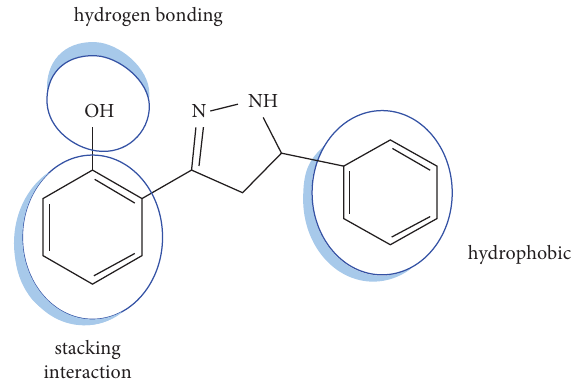
Figure 1: 3-(5-Hydroxyphenyl)-5-phenyl-2-pyrazolines have hy- drogen bonding, stacking, and hydrophobic interaction